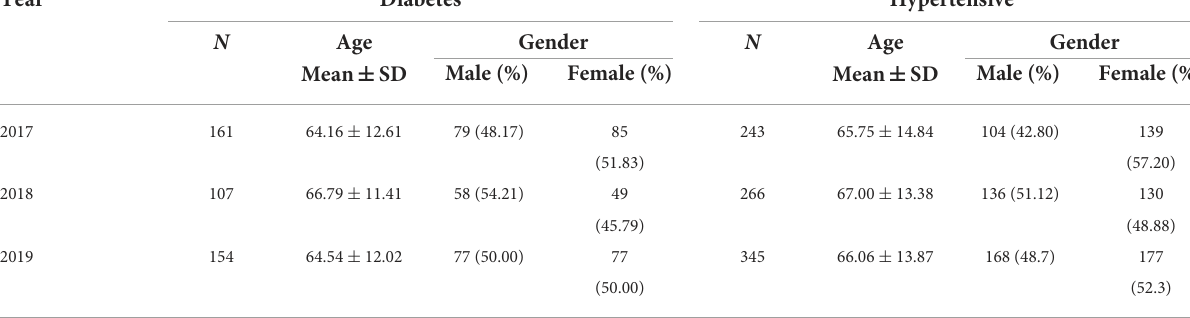
TABLE 2 Characteristics of actual cases of medical center in our study: Verification group.